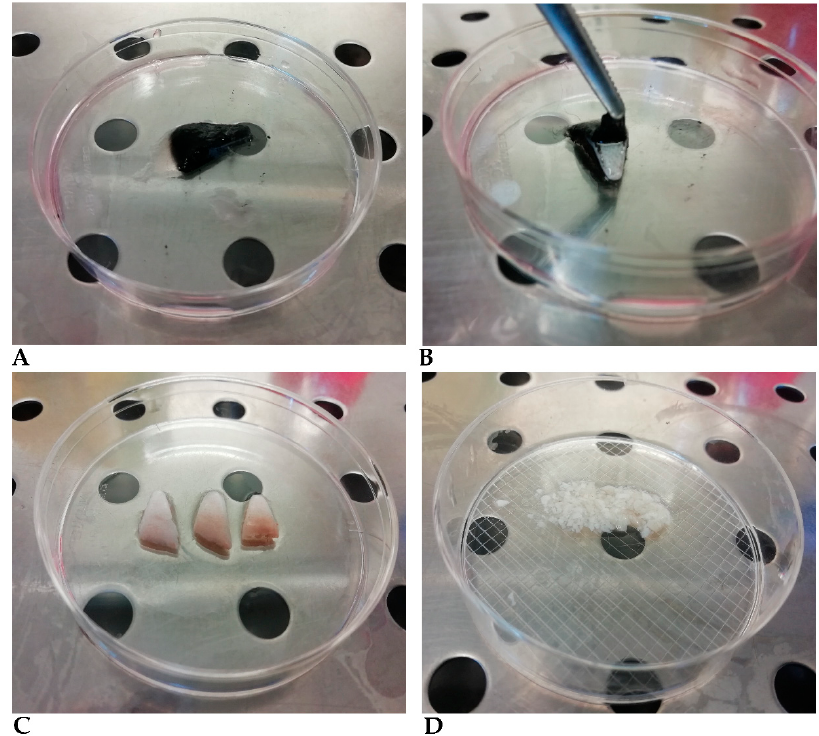
Figure 2. ( A ) Ear sample before dispase II treatment, ( B ) Ear sample after incubation with dispase II, showing the detach of the epidermis, ( C ) Ear sample after epidermis removal, ( D ) Dermis fragments cut to less than 5 mm diameter dimensions.